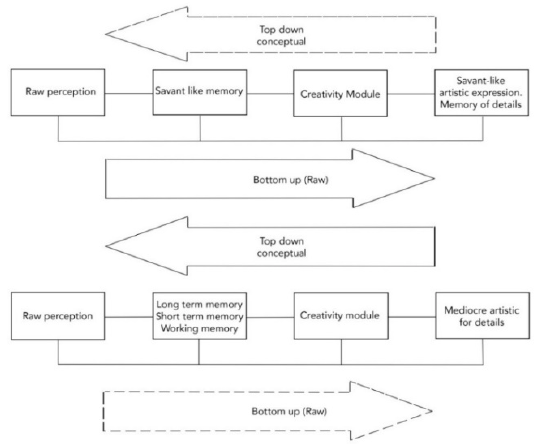
Figure 1. “top down”/“bottom up” directions in archaic and modern Homo sapiens.